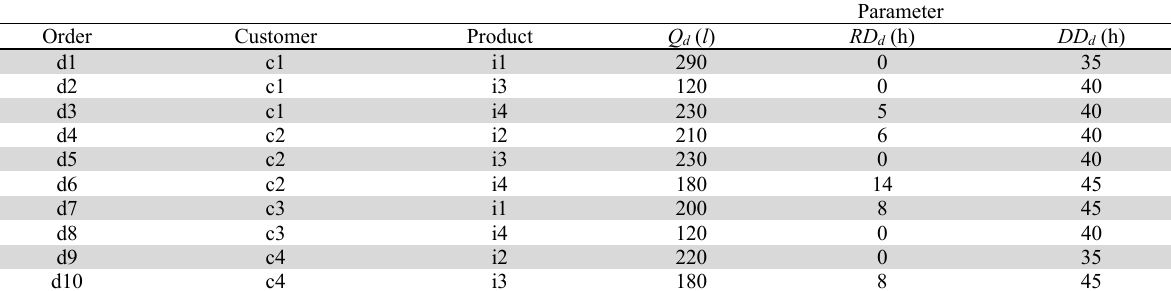
Parameters associated for each order at Example 1 Order